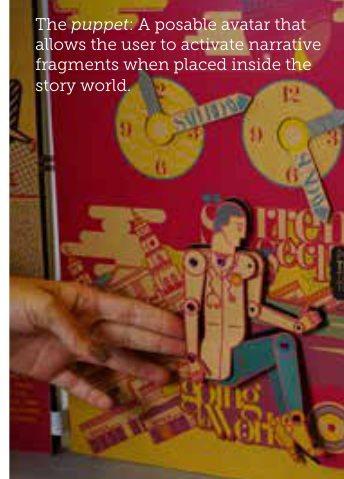
Sketchbook page. Relationships between orchestrating and contributory